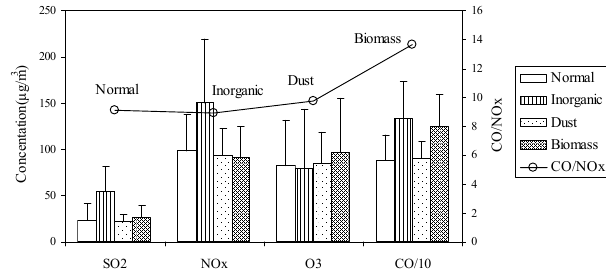
Fig. 10. The average concentrations of SO 2 , NO x , O 3 and CO during the normal period, PE1 (inogranic), PE2 (dust), and PE3 (biomass), respectively. The concentrations of CO were divided by 10 for scale visualization, and the ratios of CO/NO x were also calculated and shown in the figure. Error bars represented one standard deviation of the gaseous concentrations during different periods.